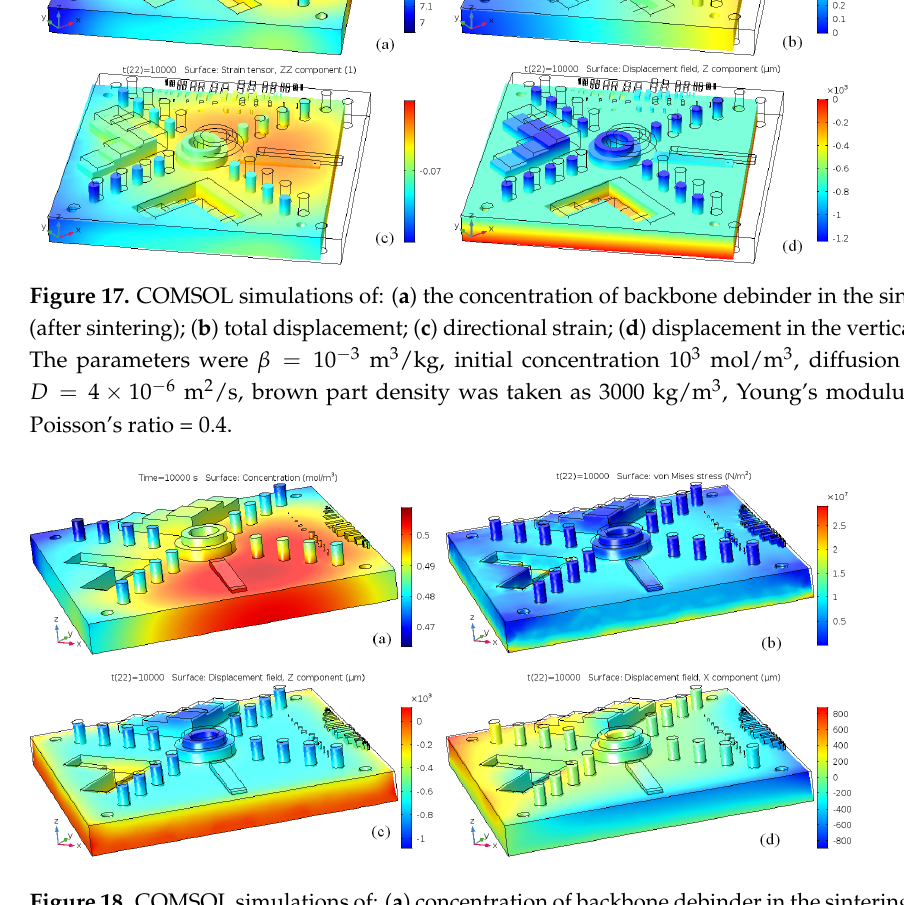
Figure 18. COMSOL simulations of: ( a ) concentration of backbone debinder in the sintering part (after sintering); ( b ) Von-Mises residual stress; ( c ) directional displacement vertically; ( d ) displacement in x . The parameters were β = 10 − 3 m 3 /kg, intial concentration 10 3 mol/m 3 , diffusion coefficient D = 4 × 10 − 6 m 2 / s , brown part density was taken as 3000 kg/m 3 , Young’s modulus = 10 GPa, Poisson’s ratio =